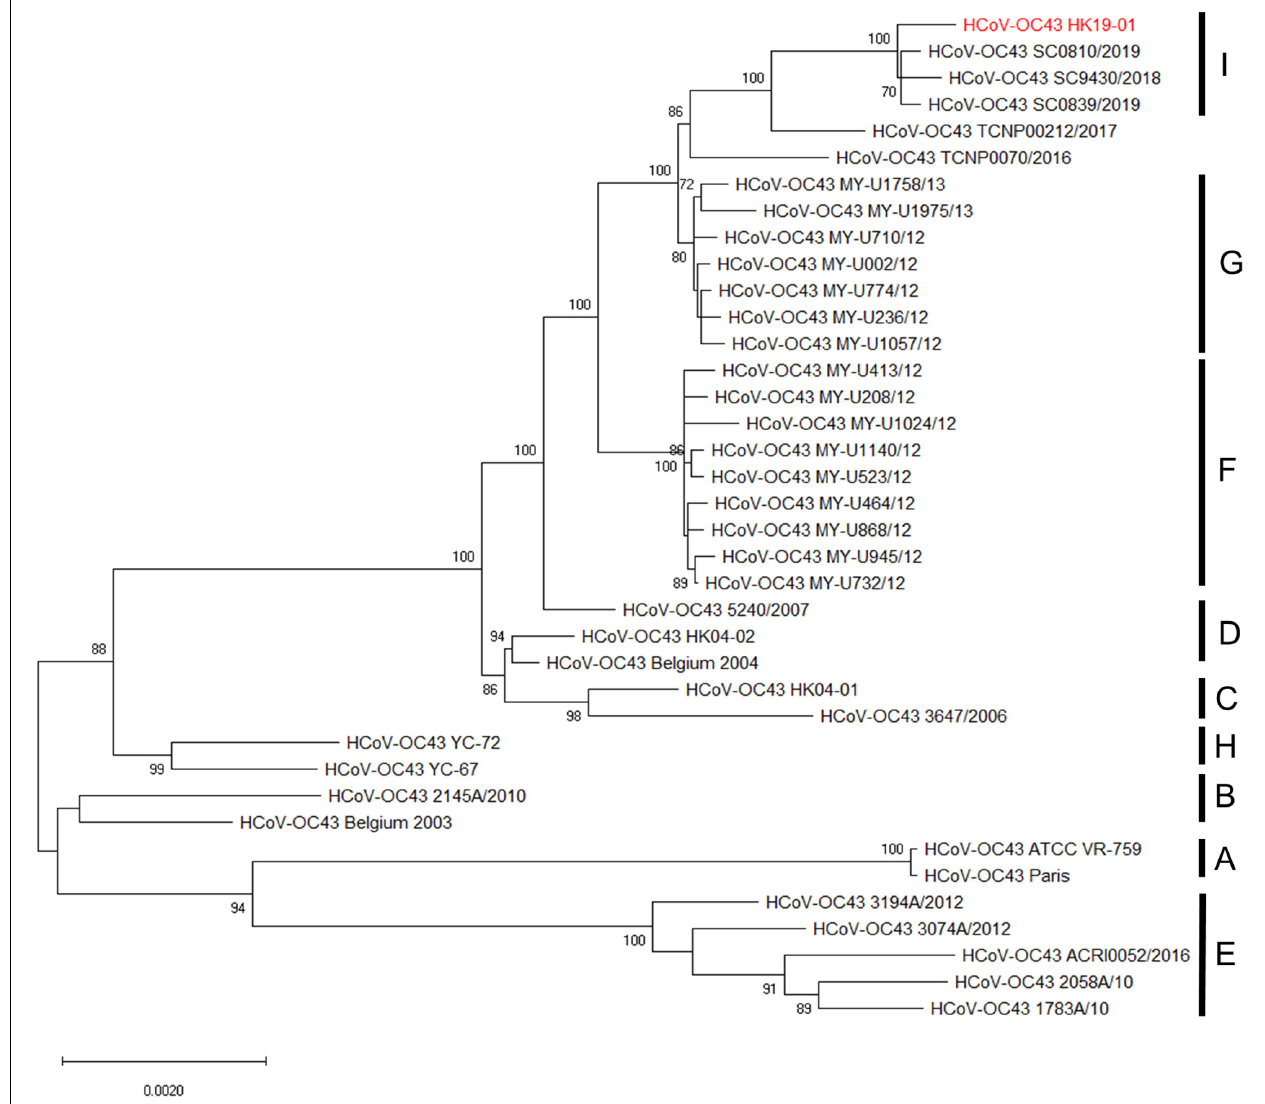
FIGURE 2 | Phylogenetic analysis of HCoV-OC43 whole-genome sequences. The tree was constructed by the maximum-likelihood method with the best-fit TN93 + G model, and bootstrap values were calculated from 1,000 trees. A total of 30,726 nucleotide positions were used for the analysis and bootstrap values over 70% were shown in the nodes. The scale bar indicates the estimated number of substitutions per 500 nucleotides. The genome sequence of HCoV-OC43 HK19-01 from the patient was indicated by red color.